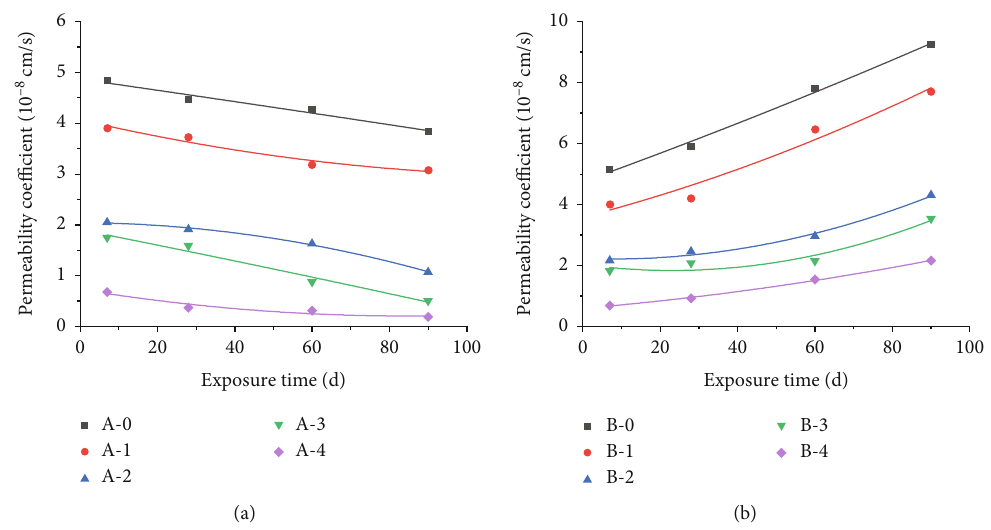
Figure 7: Regression curve of permeability coe ffi cient with immersion age: (a) soil-cement soaked in clean water; (b) soil-cement soaked in